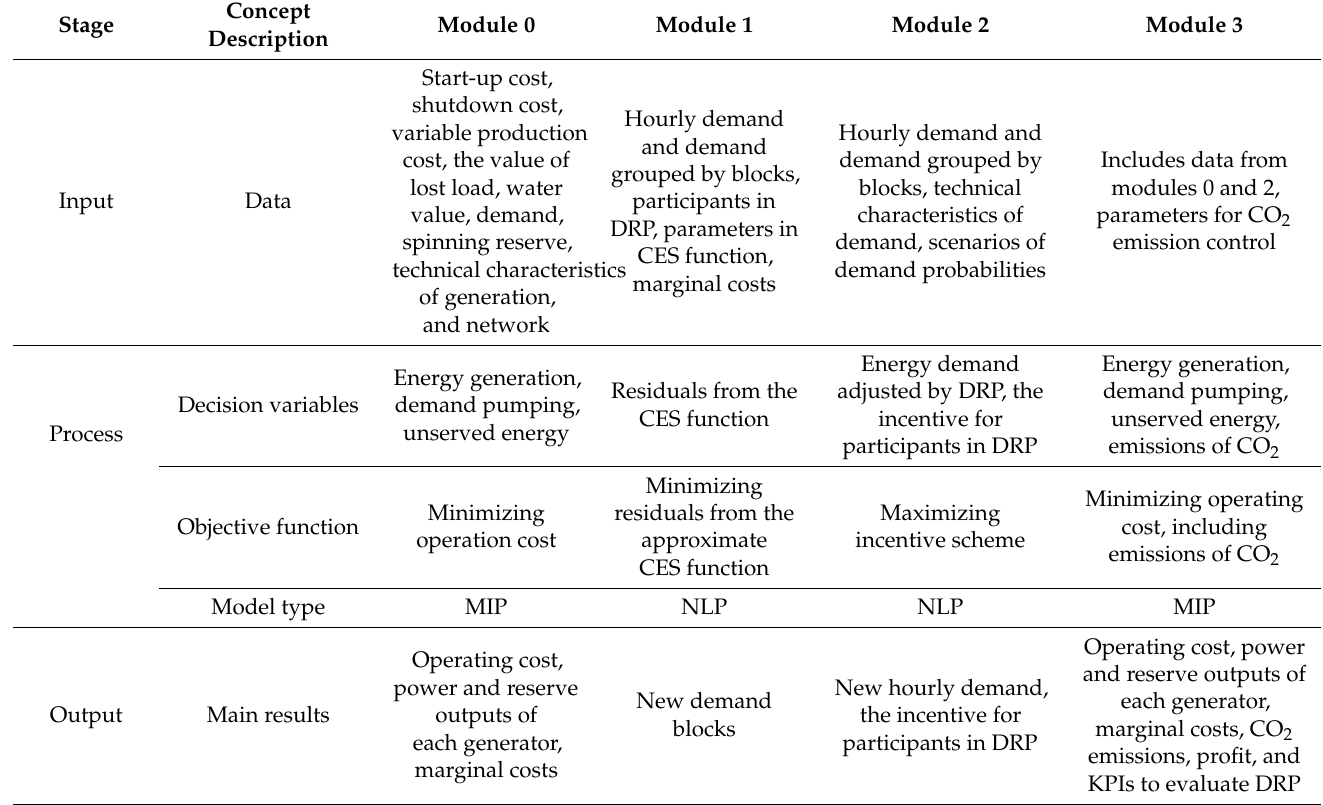
Table 3. Main modeling